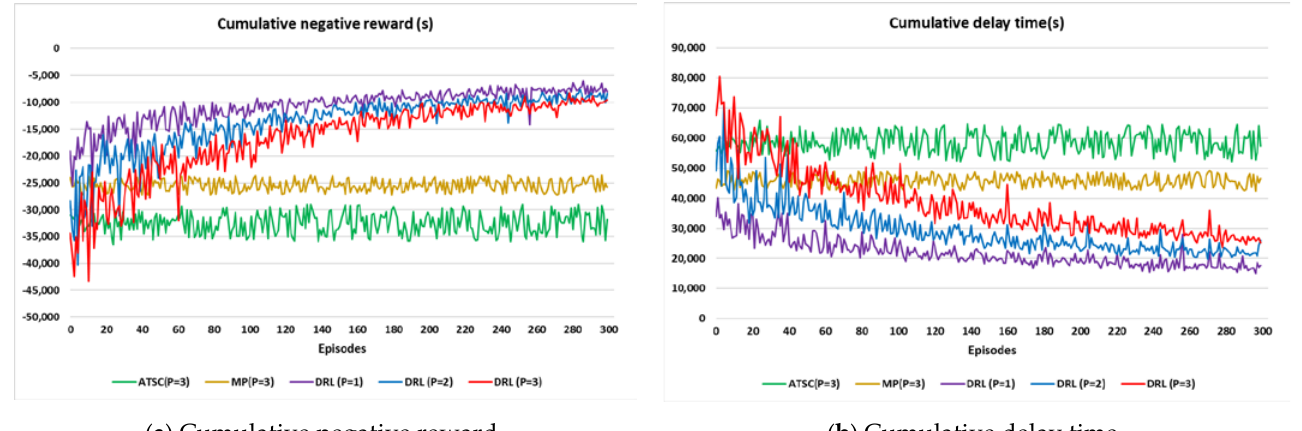
Figure 10. Cumulative negative reward and delay time of DRL, ATSC, and MP-based scenarios with different platoon sizes.